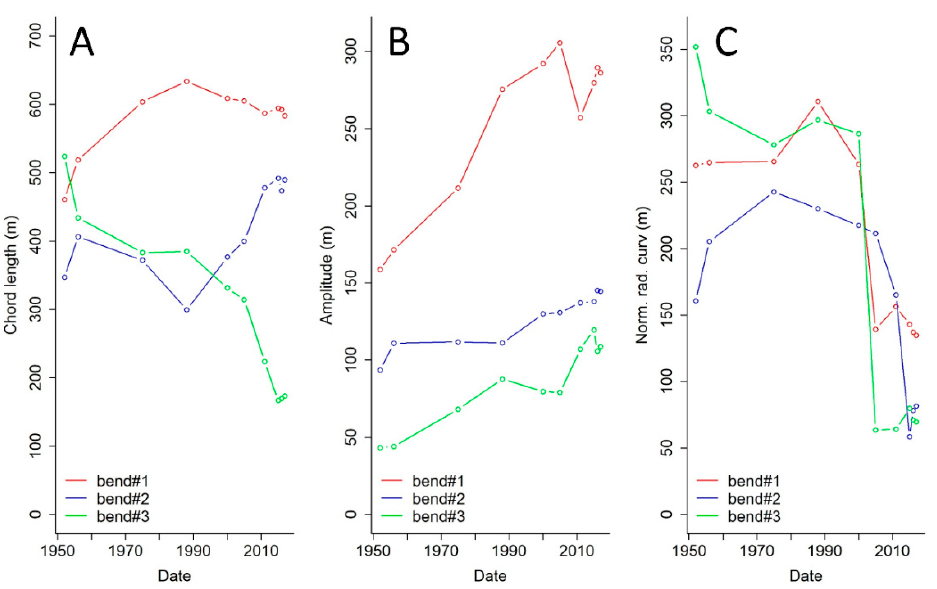
Figure 6. Parameters of meander evolution and channel shift ( A ) chord length (m); ( B ) bend amplitude (m); ( C ) width-normalized radius of curvature (m).